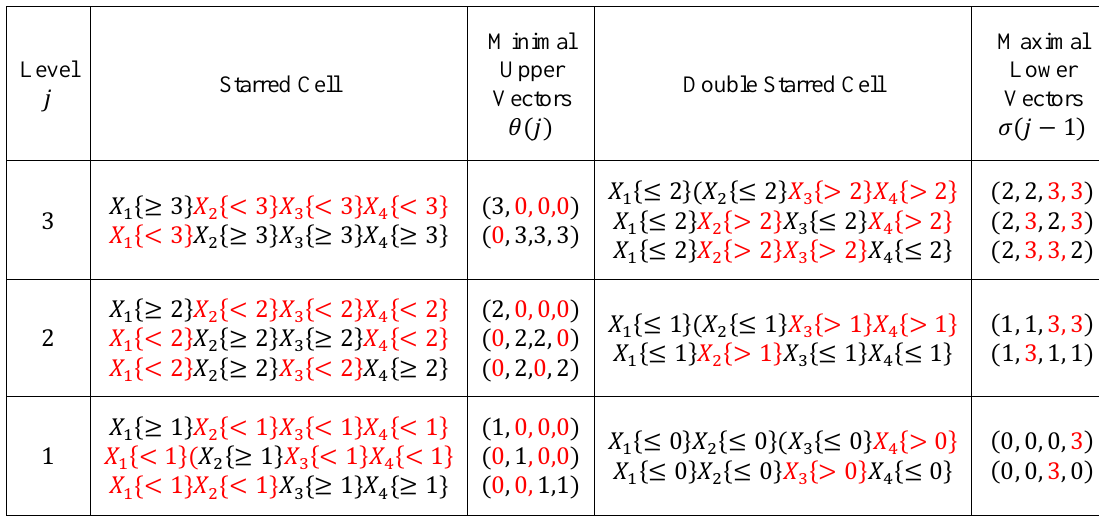
Maximal Lower Vectors 𝜎(𝑗 −